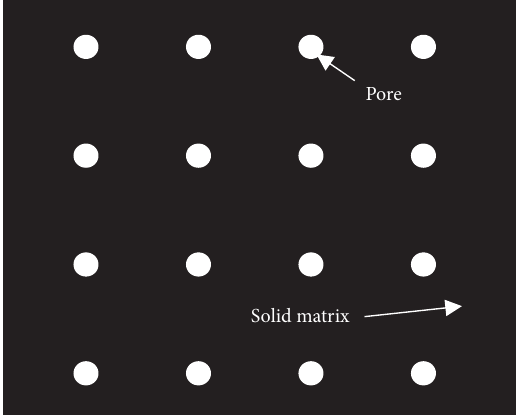
Figure 9: Schematic illustration of porosity